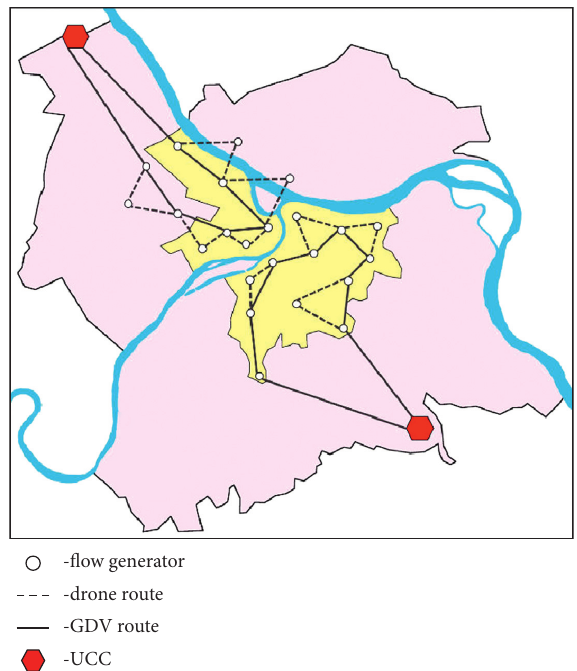
Figure 1: CL concept 1: goods delivery with ground vehicle-drone